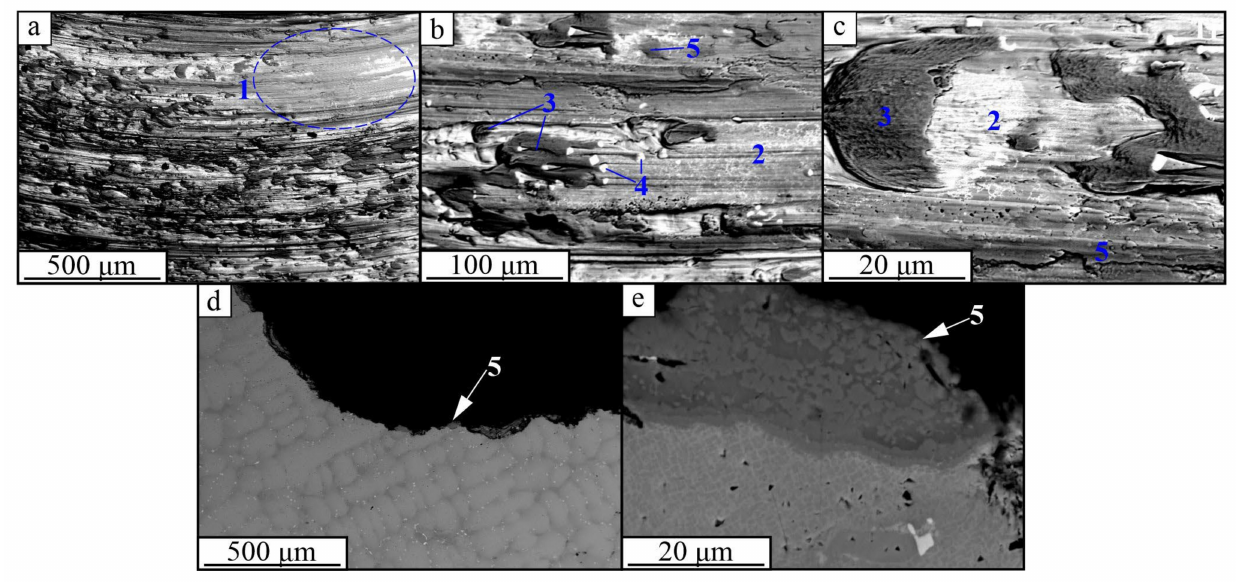
Figure 20. SEM BSE images of subsurface FSW tool structures on the worn surface ( a – c ) and below the pin/shoulder fillet worn surface without ( d ) and with tribological layer fragments ( e ): 1, 2—tribological layer-free regions; 3—transfer layer fragments; 4—primary carbides; 5—intermetallic layer fragments.